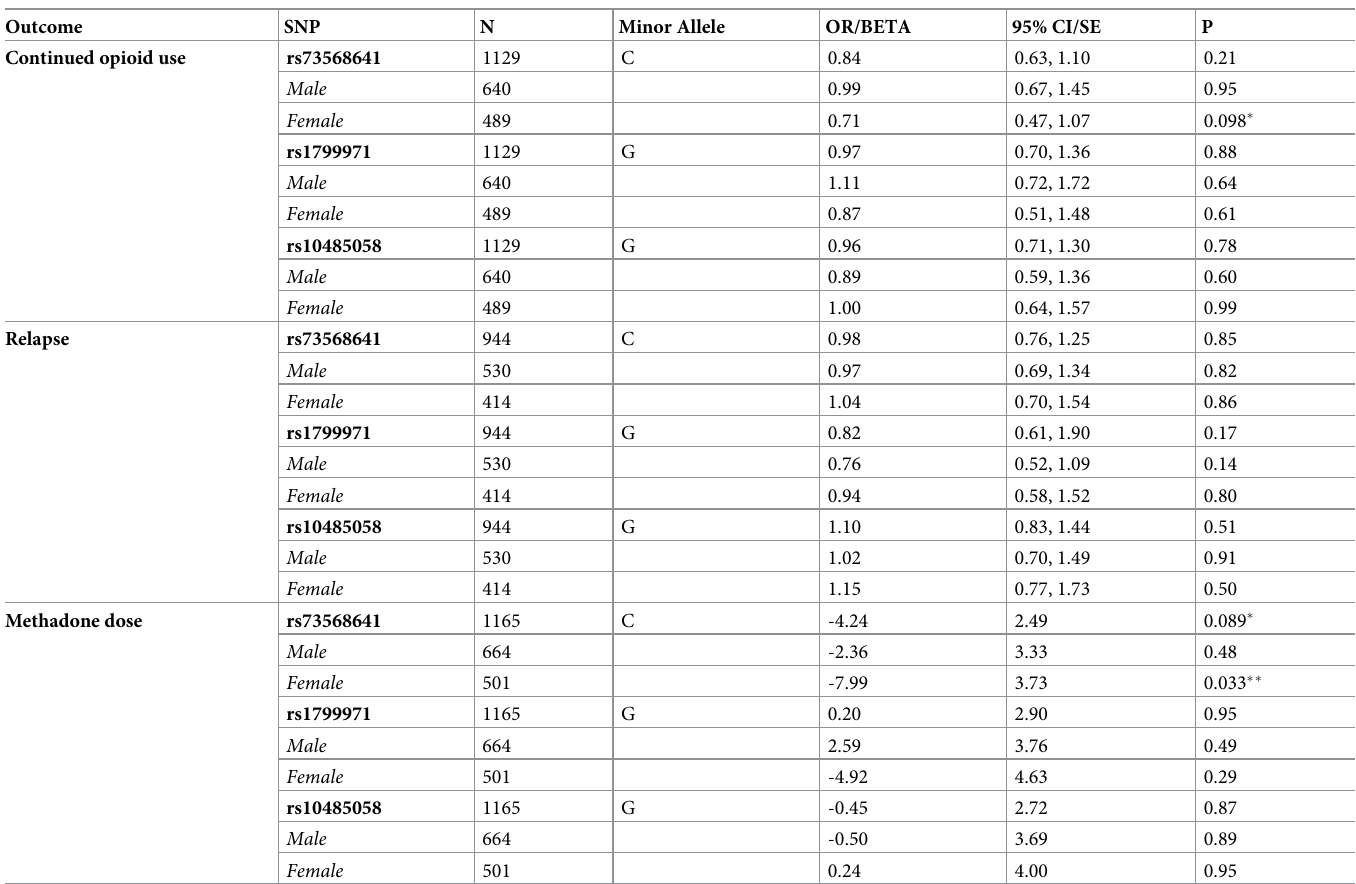
Table 3. OPRM1 SNPs and associated outcomes.